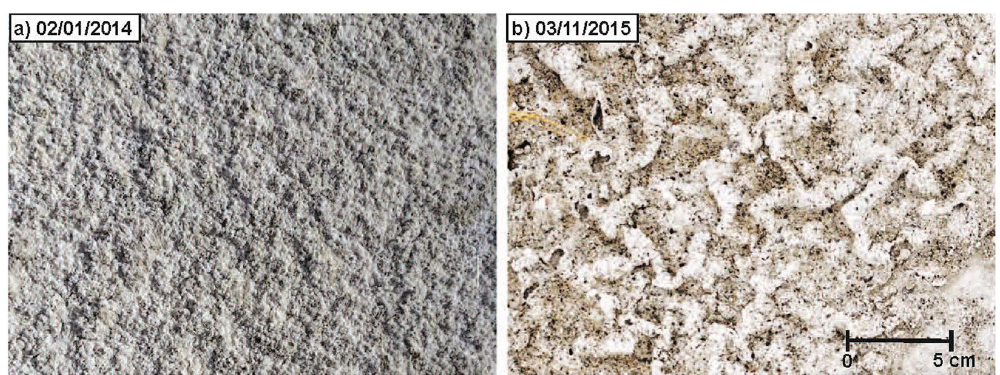
Figure 2. Comparison of surface crusts observed on ( a ) February 1 st of 2014 and ( b ) March 11 th of 2015. Images were taken before ( a ) and after ( b ) the abrupt increase in aerosol concentration (Fig. 1). The fragmented surface salt crust observed in ( b ) suggests that the breaking of surface salt crusts produces the increase in aerosol